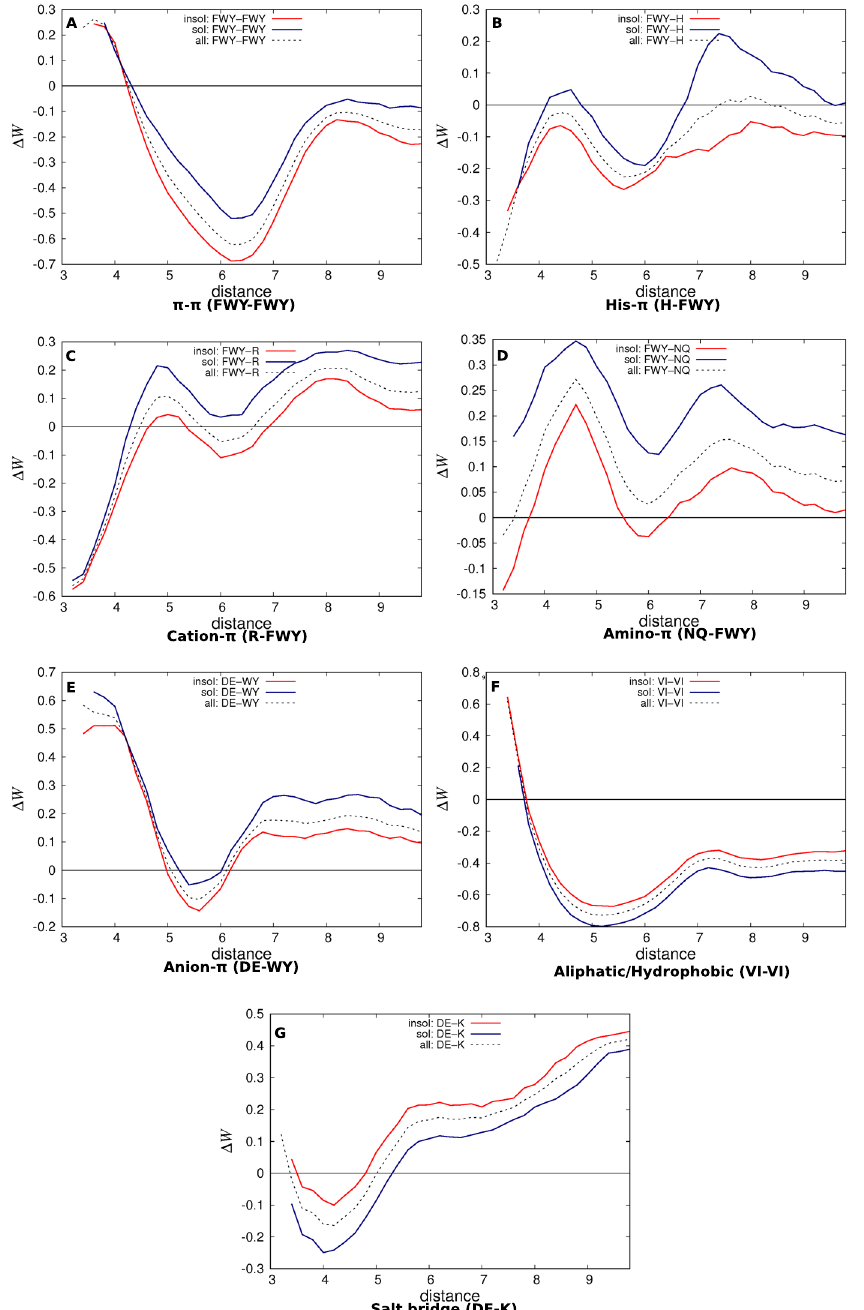
Figure 2. Residue-residue group potentials derived from datasets of soluble, aggregation-prone and all proteins ( sol  , insol  and tot  ). The energies are in kcal/mol, the distance d is computed between the residue side chain centroids of the smallest amino acids in the group, and the residue pairs are separated by at least 8 residues along the chain. Distance bins containing twenty occurrences or less are not